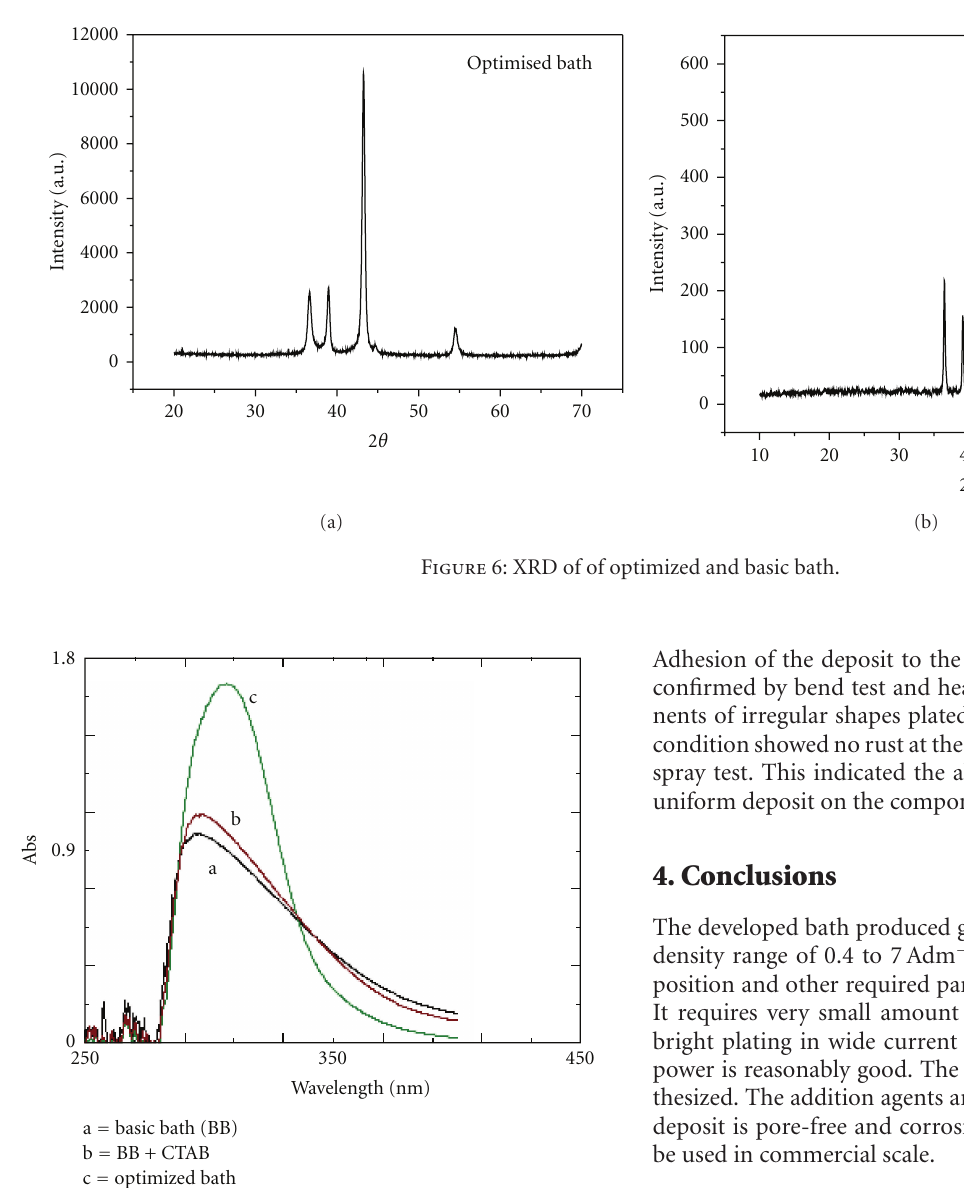
Figure 7: UV-visible spectra of Bath